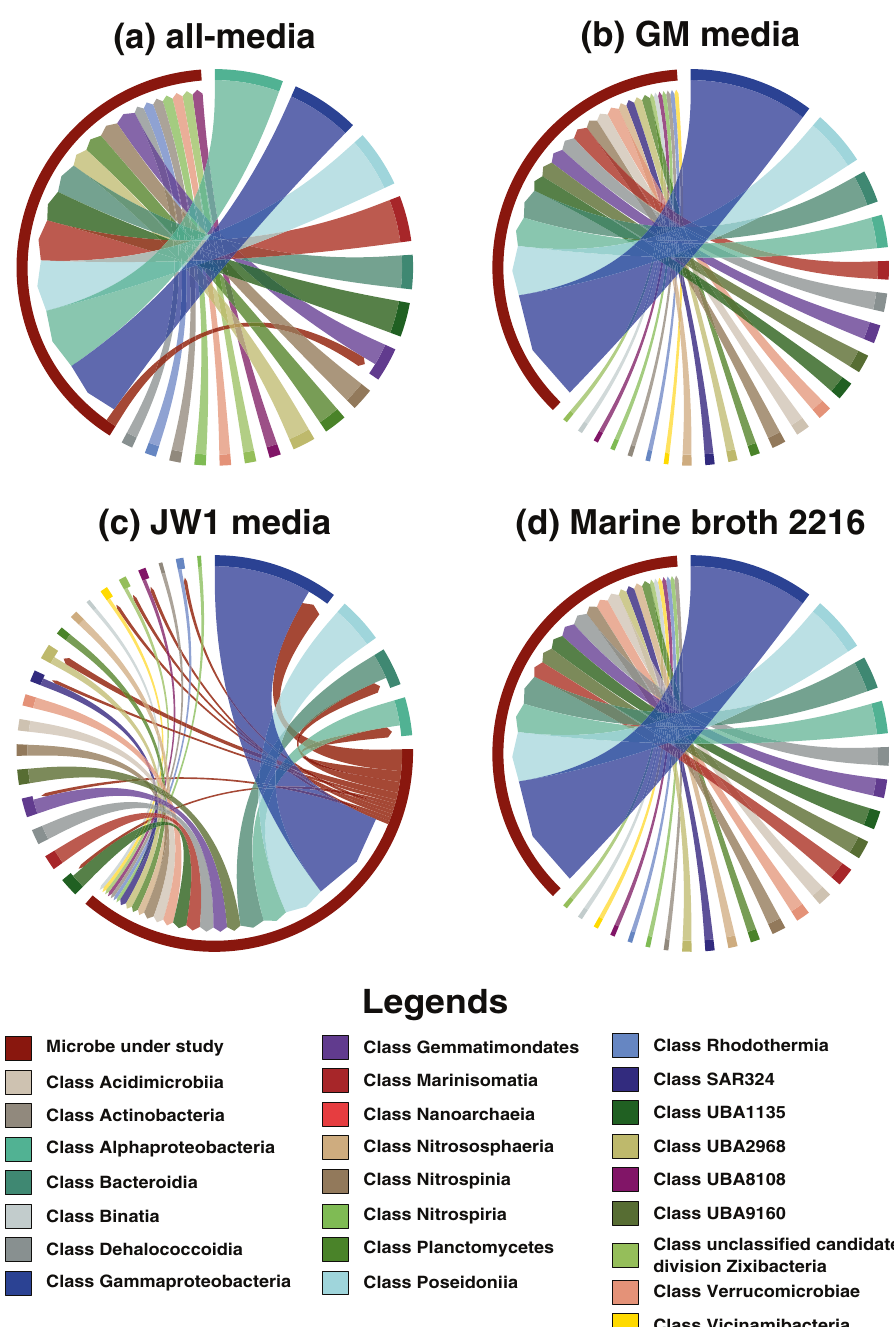
Fig. 2 Pairwise MSI interactions of Candidatus Pacearchaeota archaeon UWMA 0287 with other microbes in the community. This chord diagram shows all possible metabolic interactions between Candidatus Pacearchaeota archaeon UWMA 0287 and other microbial classes present in the Guaymas microbiome in four different media conditions ( a ) all-media, ( b ) GM media, ( c ) JW1 media, ( d ) Marine Broth 2216. All the interacting microbes are grouped under their corresponding microbial class except Candidatus Pacearchaeota archaeon UWMA 0287. The chord starts from the donor microbe/class towards the recipient microbe/class. The thickness of the chord represents the number of microbes participating in the interaction from the same class. The colours are mapped to microbial ammonia oxidation and transformation of organic compounds [2, 26 – 28]. Therefore, in order to understand and highlight the functional importance of “ microbial dark matter ” in hydrothermal plumes, a signi fi cant focus of this study is on the archaeal members of this community and their interactions with other archaeal and bacterial species in Guaymas basin (Refer Supple-